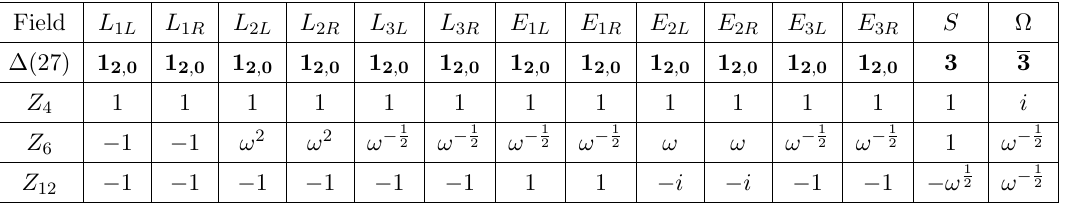
Z 4 Z 6 Z 12 . (cid:10) (cid:10) (cid:10)